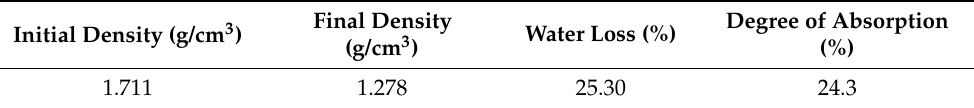
Table 5. Physical properties of gypsum plaster specimen.